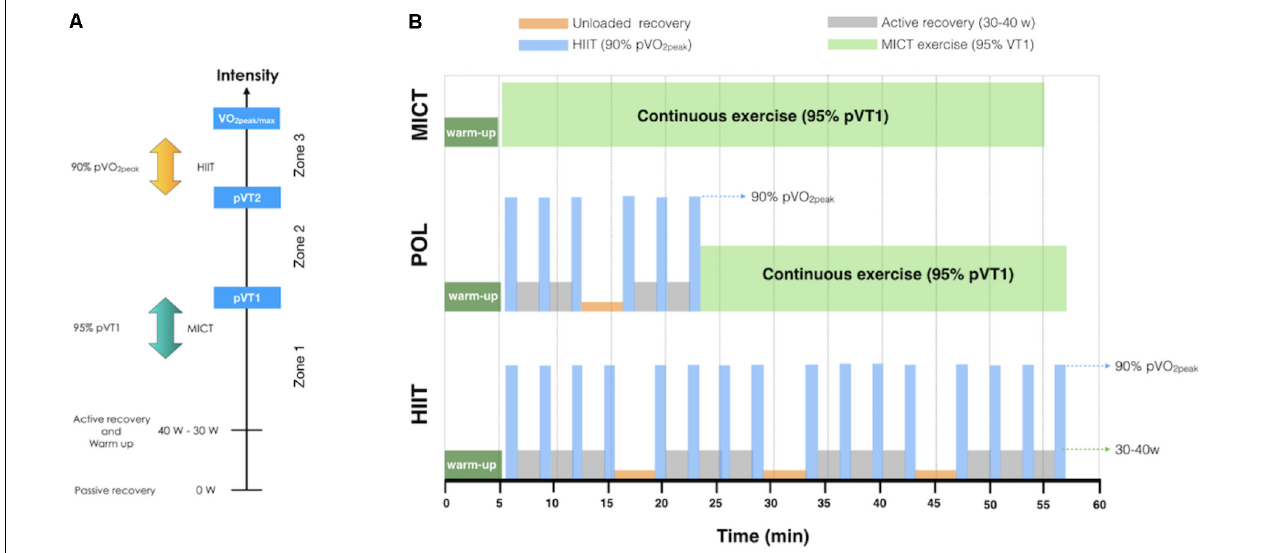
FIGURE 2 | Exercise intensity and training protocols. (A) Training zones and intensities used in the exercise training protocols, (B) Schematic representation of training protocols. VO 2peak / max : Peak or maximal oxygen uptake; pVT2: power at ventilatory threshold 2; pVT1: power at ventilatory threshold 1; POL: polarized volume training; MICT: moderate-intensity continuous training; HIIT: high-intensity interval training; W: